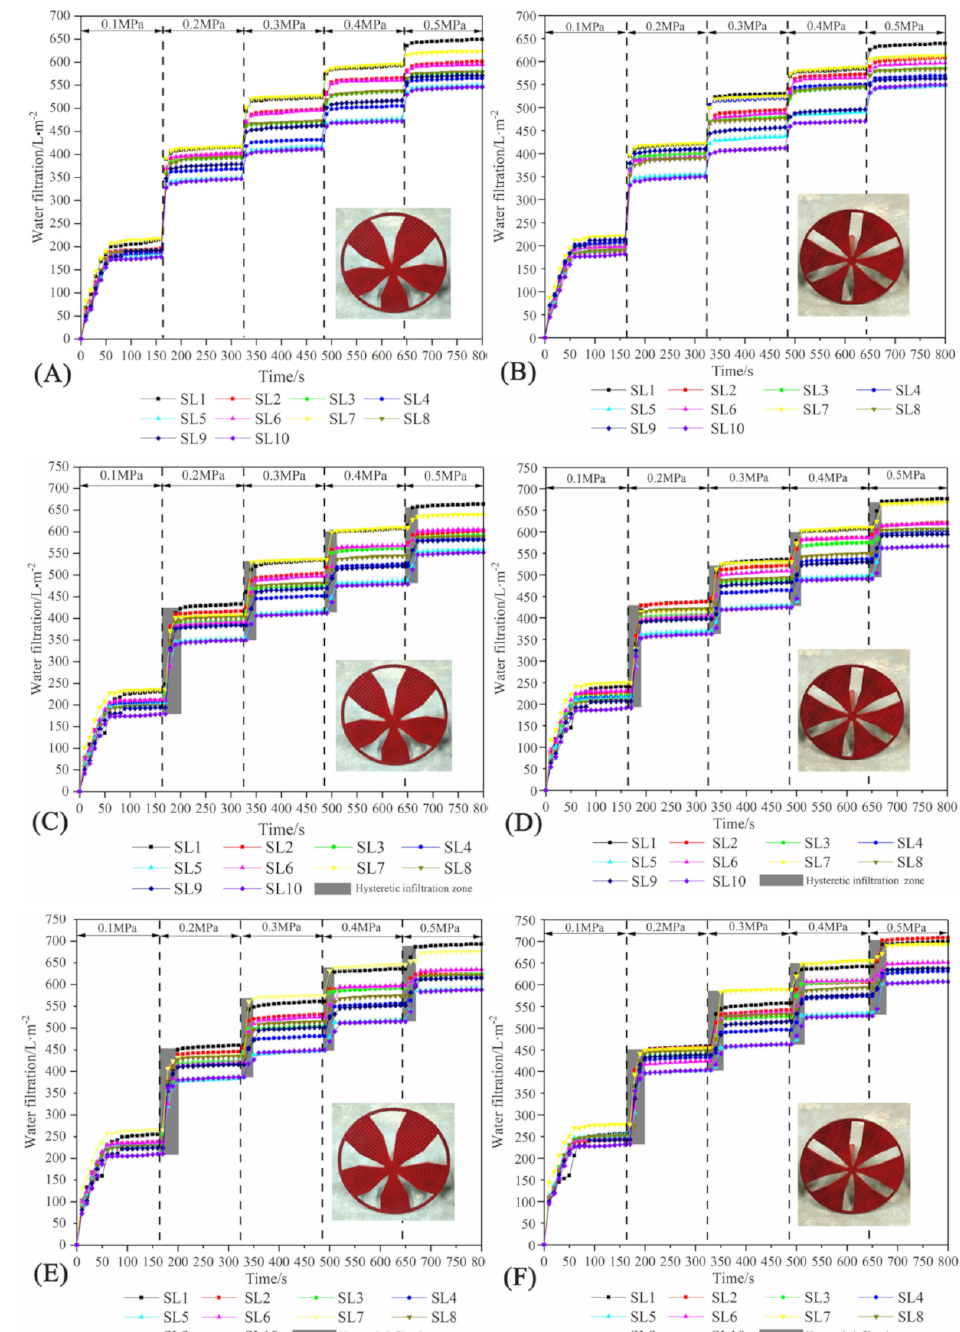
Figure 9. Water filtration time curves: ( A ) cutter head CH1, rotation speed of the cutter head = 0 rpm; ( B ) cutter head CH2, rotation speed of the cutter head = 0 rpm; ( C ) cutter head CH1, rotation speed of the cutter head = 0.5 rpm; ( D ) cutter head CH2, rotation speed of cutter head = 0.5 rpm, ( E ) cutter head CH1, rotation speed of the cutter head = 1.0 rpm, ( F ) cutter head CH2, rotation speed of the cutter head = 1.0